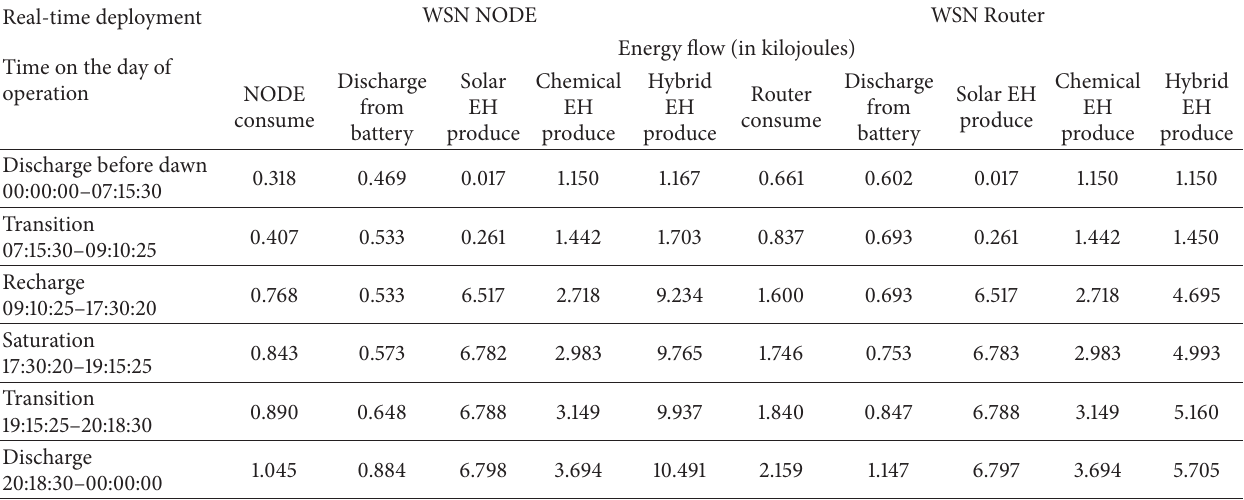
Figure 7: (a) Photograph showing the solar-based EH is charging the energy storage. (b) Prototype of hybrid energy harvester-based autonomous WSN NODEs. Table 4: Cumulative energy flows through the subcomponents of hybrid EH-based autonomous WSN NODE and Router at different time of the